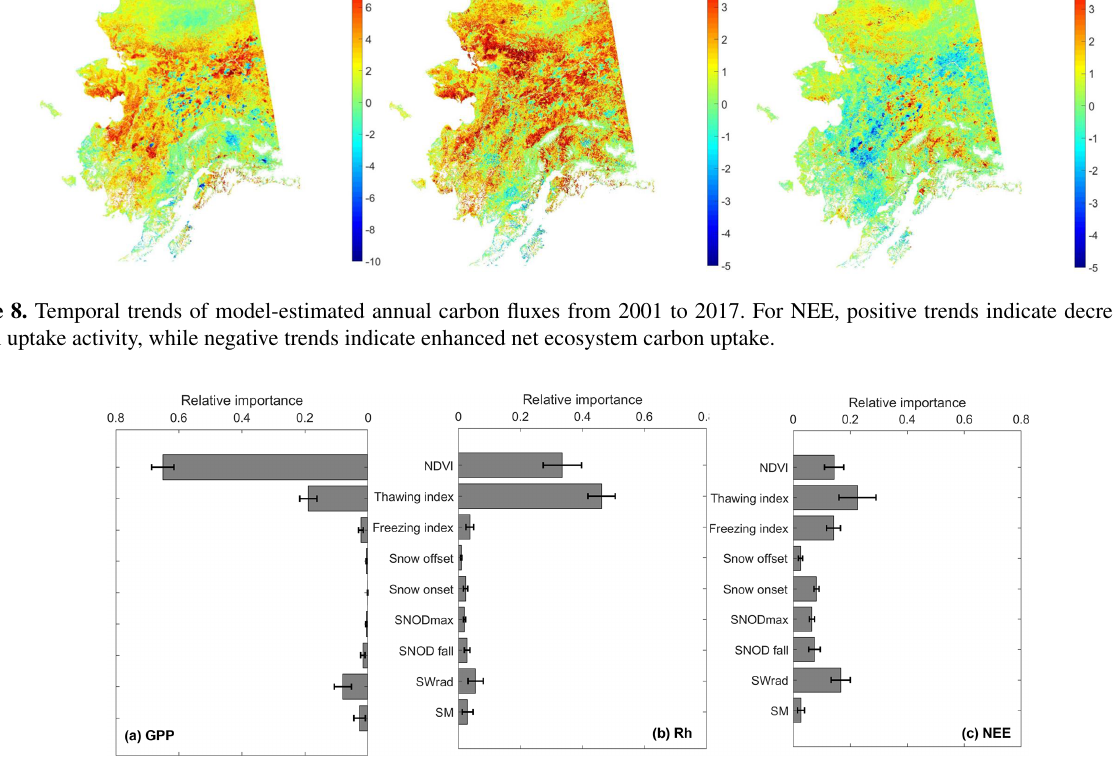
Figure 9. Mean relative importance values of selected environmental variables in controlling model-estimated annual carbon fluxes in Alaska (in which (a) GPP, (b ) Rh, and (c) NEE are shown). The importance values were averaged for four major vegetation types (forest, shrub, herbaceous, and wetlands; Fig. 2), and the error bar represents their standard deviation across the different vegetation types. The nine environmental variables are summer (June–August) normalized difference vegetation index (NDVI), the annual thawing and freezing indexes, snow offset and onset, mean snow depth averaged from January to March (representing annual maximum snow depth), snow depth averaged during the early snow season (from October to November), mean annual downward solar radiation, and root zone soil moisture during the thaw season. The annual thawing and freezing indexes represent the sum of MODIS land surface temperature (LST) above 0 ◦ C and below 0 ◦ C throughout the year,